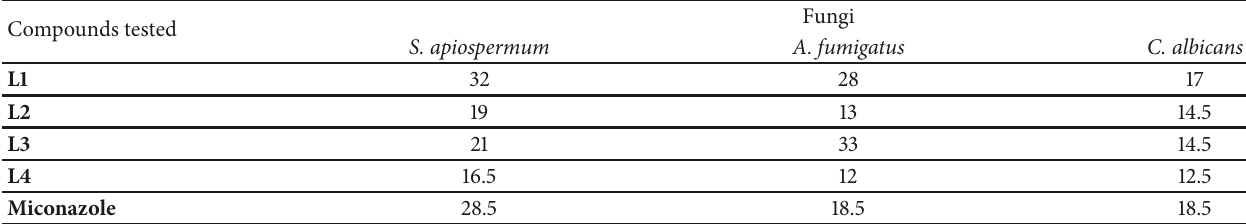
Table 1: Antifungal activities determined on solid medium and expressed by the diameter of the growth inhibition zone (mm). Compounds tested